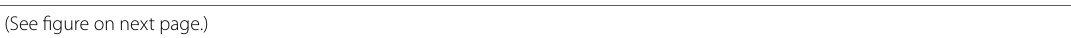
Fig. 2 Pacs-2 gene deficiency contributes to lipid accumulation in tubular cells of diabetic mice. A Representative images showing lipid deposition by immunohistochemistry of Adipophilin and Oil Red O staining of kidney from mice. Scale bars: 50 μm. B and C Relative Adipophilin expression and Oil Red O staining area. D Measurement of the mRNA expression of selected markers. E and F Western blot and quantification of FN and α-SMA. All data are presented as means SD; *p < 0.05, **p < 0.01, ***p < 0.001. n ±